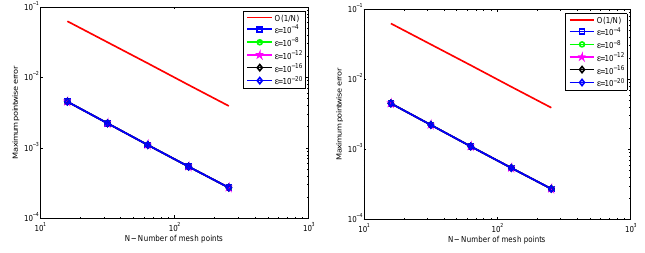
Figure 3. ε -uniform convergence with nonstandard fitted operator method in log-log scale for Example 1 and Example 2 respectively.